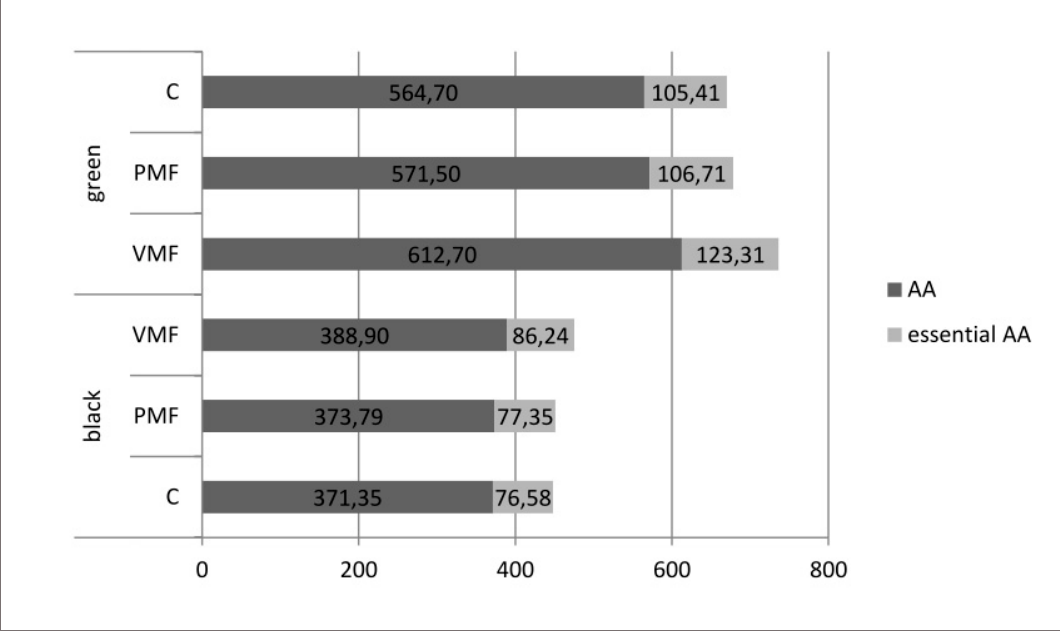
Figure 4. Impact of a permanent or variable magnetic field on the total content of amino acids (AAs) and essential amino acids (essential AAs) in the tea infusion samples (mg L − 1 ). PMF: permanent magnetic field; VMF: variable magnetic field.